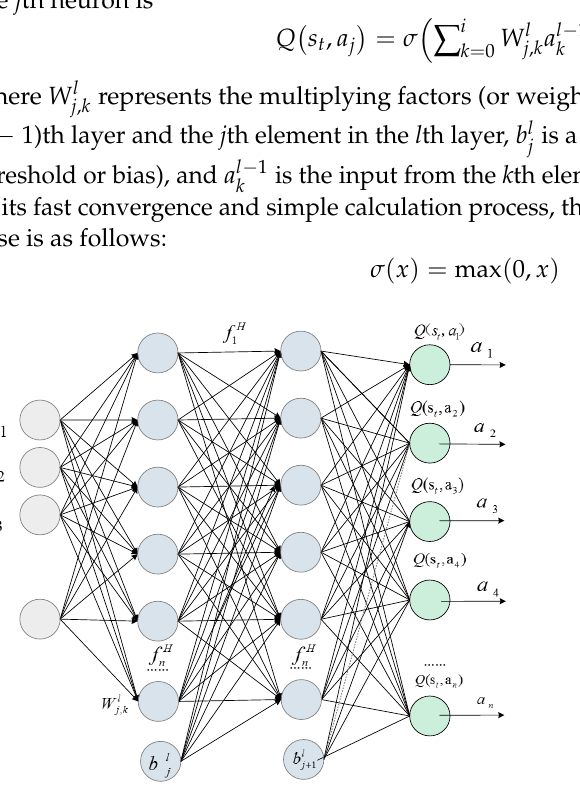
Figure 5. The neural network of the deep Q-learning